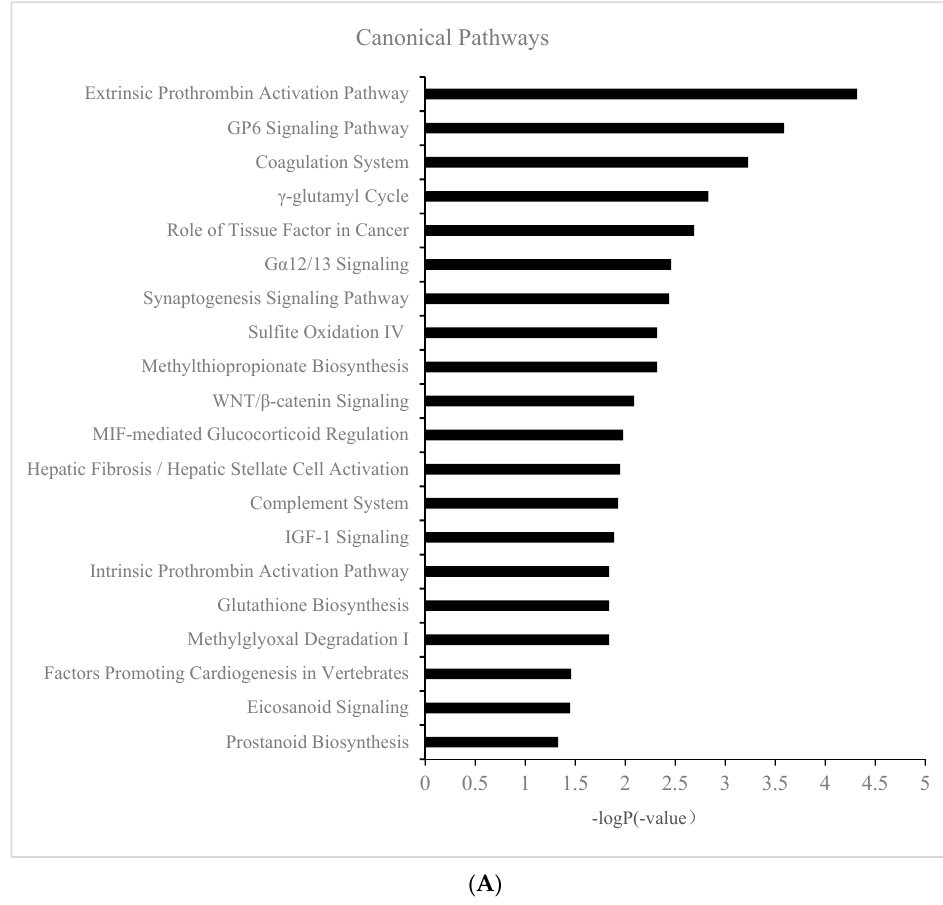
( B ) Figure 8. ( A ) Biological processes by IPA ( p value < 0.05) at GD 20 d. ( B ) Changes in coagulation- related pathways at GD 14 d, GD 18 d, and GD 20 d. To assess changes in coagulation-related proteins, their relative abundances were an- alyzed during pregnancy. MOR8A3 glycoprotein 6 (platelet) was expressed at low levels in early pregnancy but upregulated at GD 14 d and maintained at high levels before de-